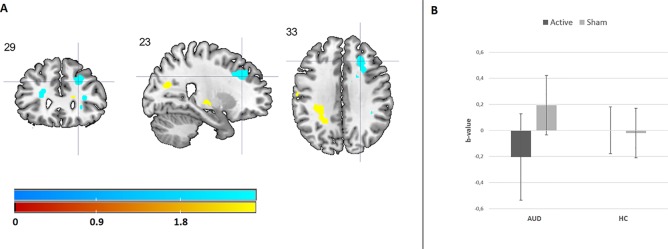
This figure shows the trend-significant interaction between emotion (alcohol, neutral, positive, negative) and stimulation (rTMS, sham) within the superior frontal gyrus. (A) This panel shows the location for the interaction in the bilateral superior frontal gyrus. For illustrative purposes, these results are depicted at a p < 0.001 uncorrected threshold (B). This panel shows the interaction within the peak voxel in the right superior frontal gyrus, based on the extracted beta weights.